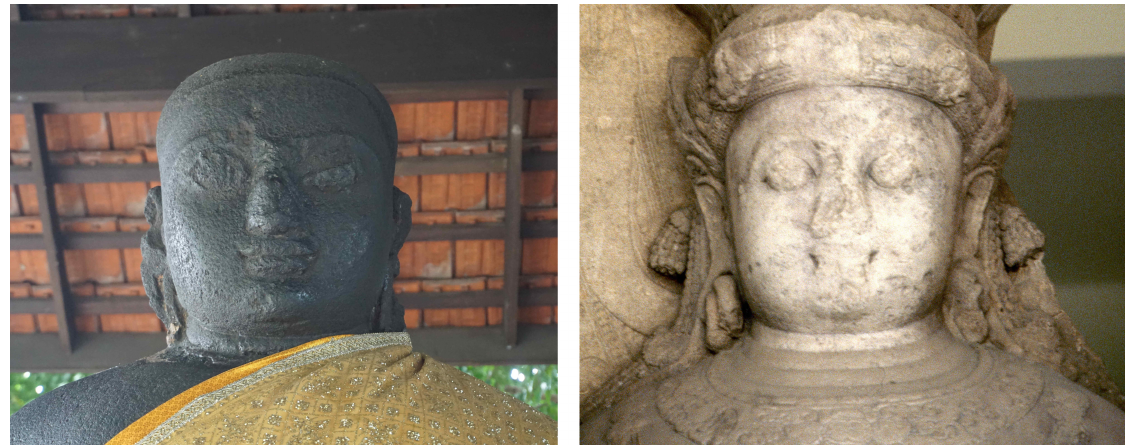
Figure 6 Two faces of Kṛtanagara. Left: Joko Dolog (Mahākṣobhya / Jñānaśivavajra). Licence: CC BY-SA 3.0. Source: photodharma.net. Right: Monumental Vajramahākāla. Courtesy of the John C. and Susan L. Huntington Photographic Archive of Buddhist and Asian Art. Scan